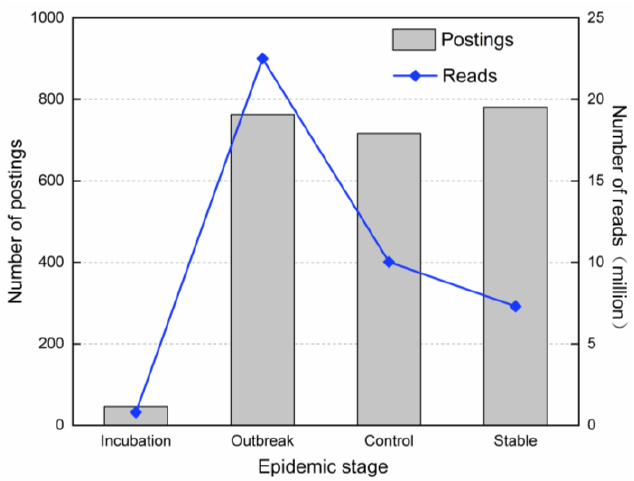
Figure 5. Stage characteristics of government information supply and public information demand.